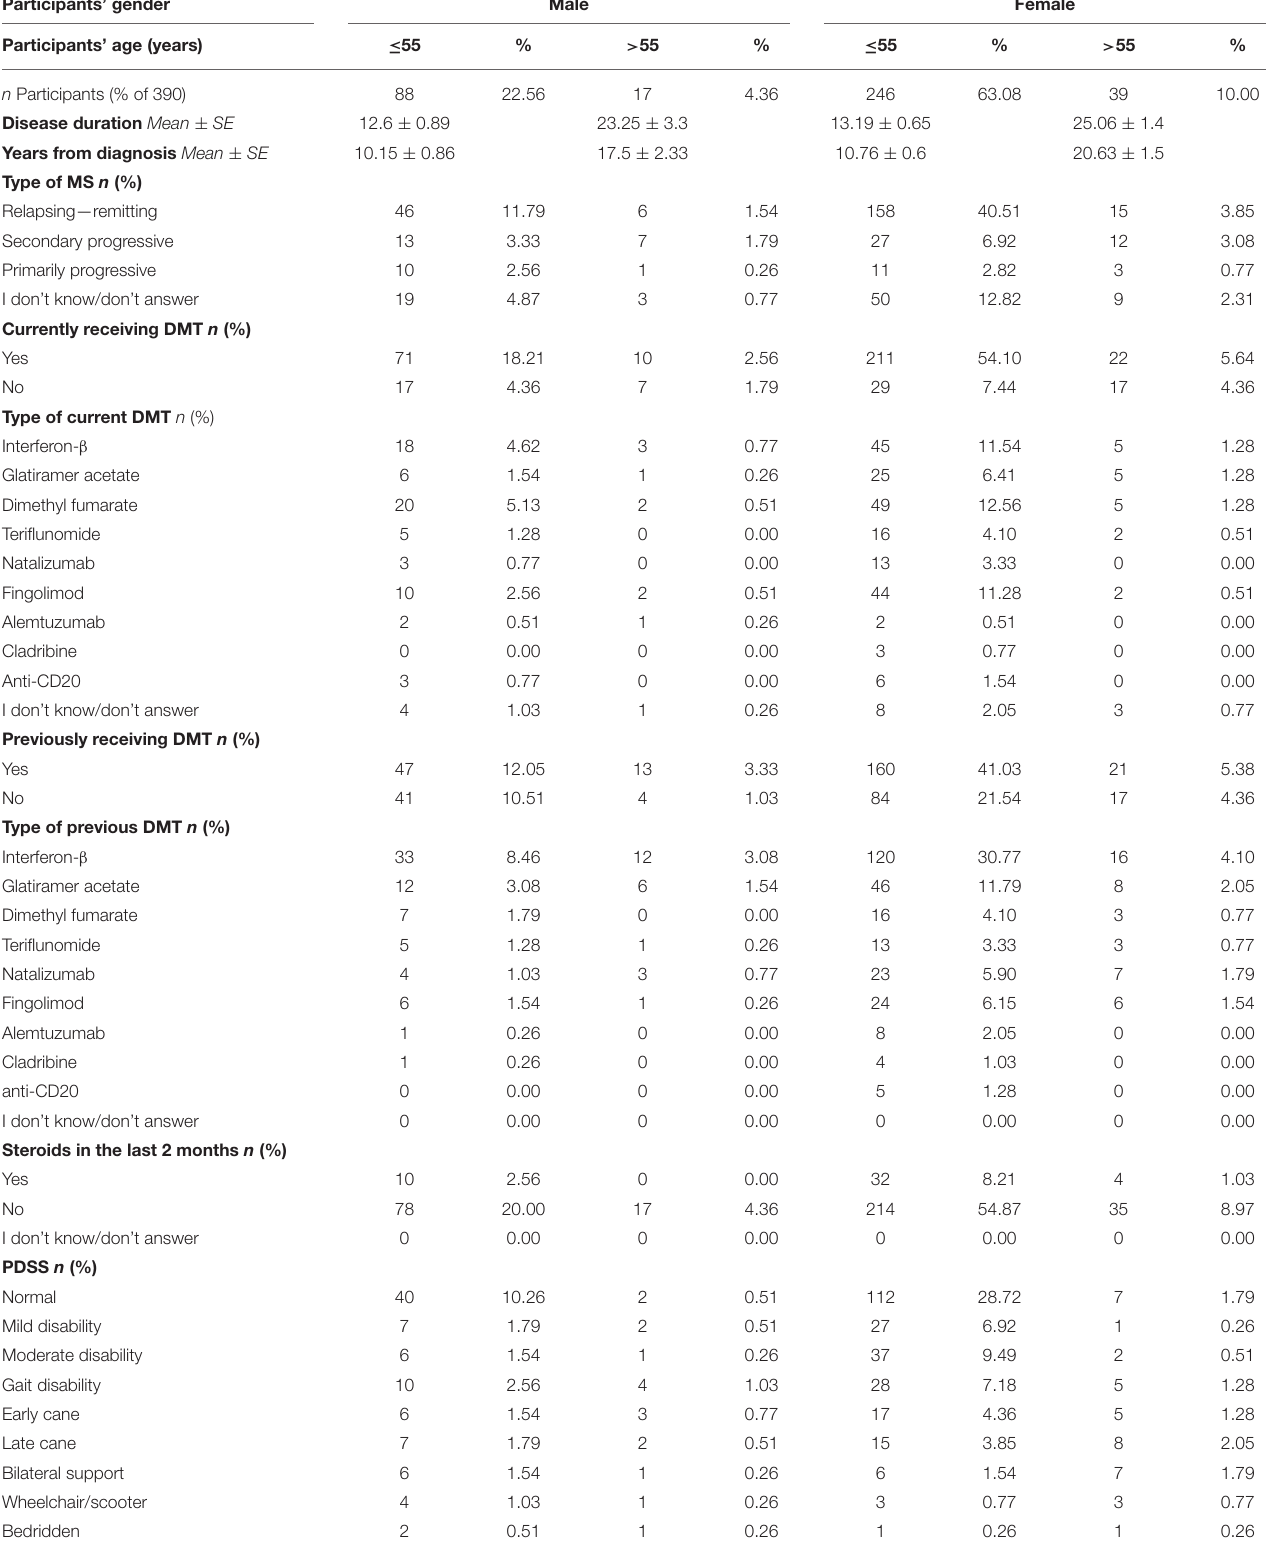
TABLE 2 | Clinical characteristics of